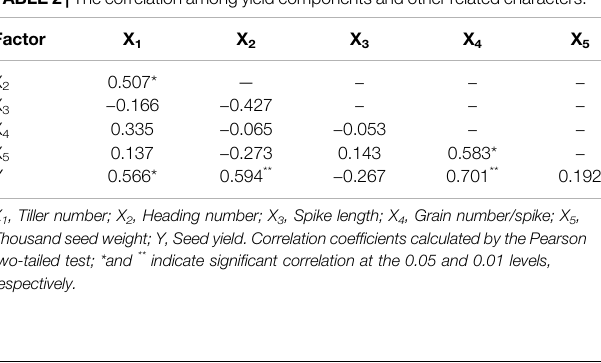
TABLE 3 | Results of two-way ANOVAs for the effects of water, nitrogen and their interactions on germination and T 50 of L. chinensis.